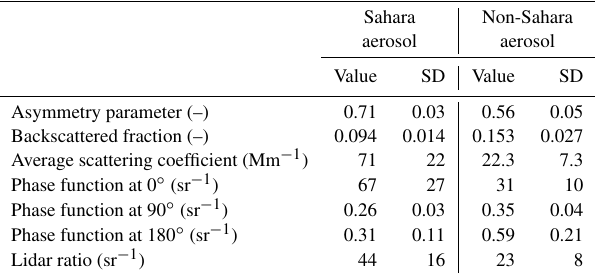
Table 2. Characteristics of the two types of aerosols.